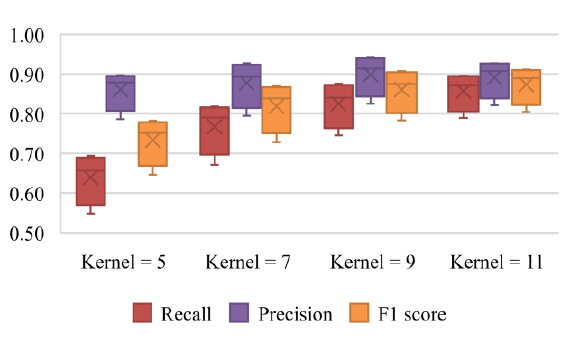
Figure 7. Performance of AdaBoost.M2